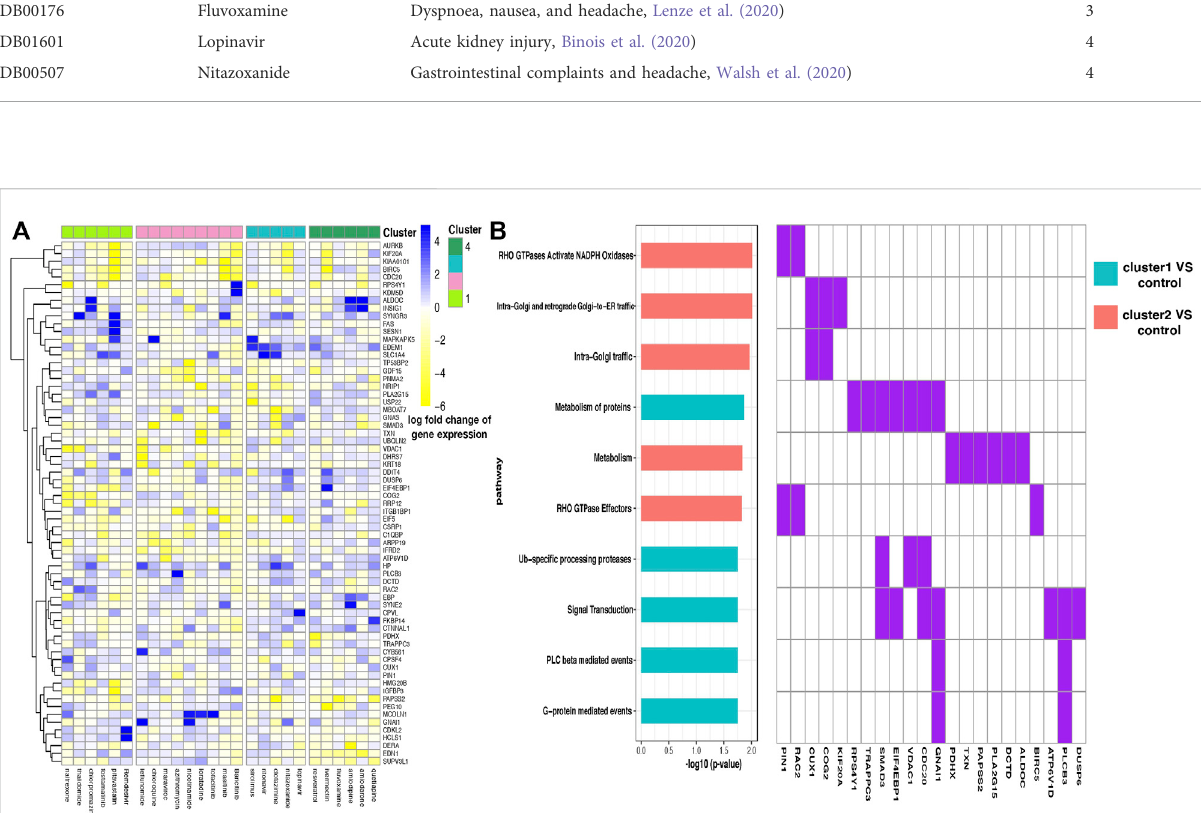
expression levels on the selected 67 SLDA genes is shown in Figure 4A. Because representative AEs of drug clusters 3 and 4 are relatively mild and the AEs in clusters 1 and 2 are more severe and characteristic, we merged drug clusters 3 and 4 as the control cluster. SLDA genes showing differential expression patterns in the